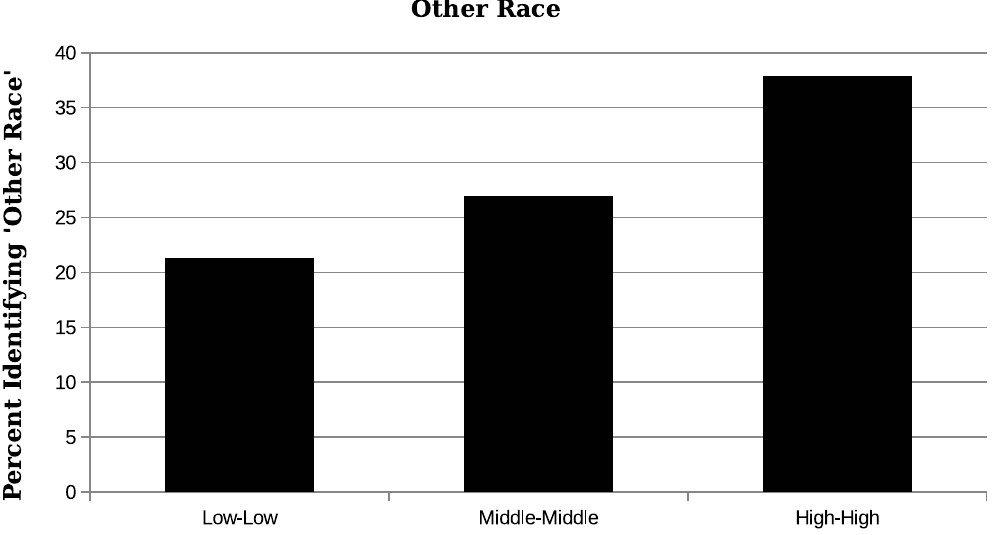
Figure 1: Hispanic Racial Identification by Segregation and Levels of Hate Crime Note: “Low-Low” represents the lowest terciles of Hispanic D and (ln) Anti-Hispanic Hate Crimes. Examples of“Low-Low” MSAs include Albuquerque, NM and Orlando, FL.“Middle-Middle” represents the middle terciles of Hispanic D and (ln) Anti-Hispanic Hate Crimes. Examples of“Middle-Middle” MSAs include Dallas-Fort Worth, TX and Denver, CO.“High-High” represents the highest terciles of Hispanic D and (ln) anti-Hispanic Hate Crimes. Examples of“High-High” MSAs include Los Angeles, CA and Boston,